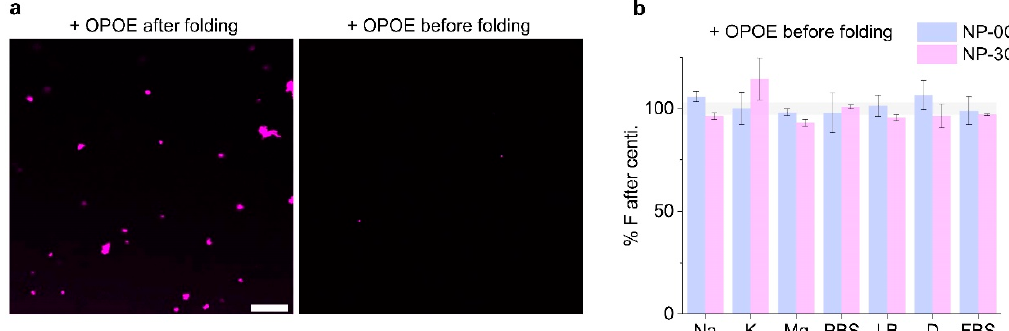
Figure 6. Adding surfactant prevents nanopore aggregation and precipitation. ( a ) CLSM images of Cy3-labeled NP-3C ( magenta ) in FBS 48 h after folding, with OPOE added at 48 h ( left ), or prior to folding ( right ), all images collected under identical conditions, scale bar 50 µ m; ( b ) fluorescence analysis of the supernatant fraction after centrifugation of NP-0C ( blue ) and NP-3C ( magenta ) folded in the presence of OPOE. Error bars represent the averages of three independent experiments.